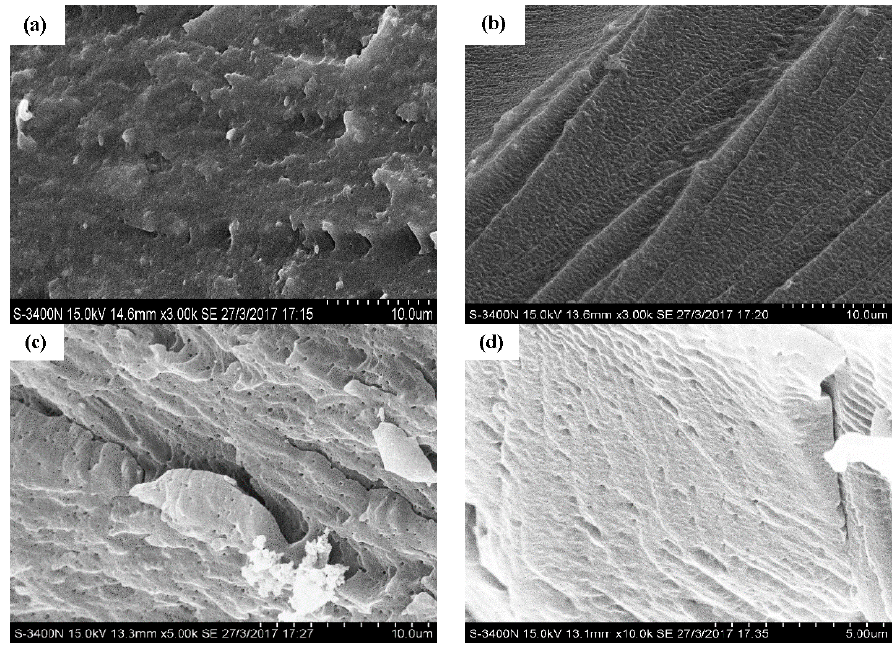
Figure 8. The morphologies of the epoxy resin matrix, ( a ) control; ( b ) 180 cycles; ( c ) 270 cycles; ( d ) 360 cycles. Polymers 2017 , 9 , 652